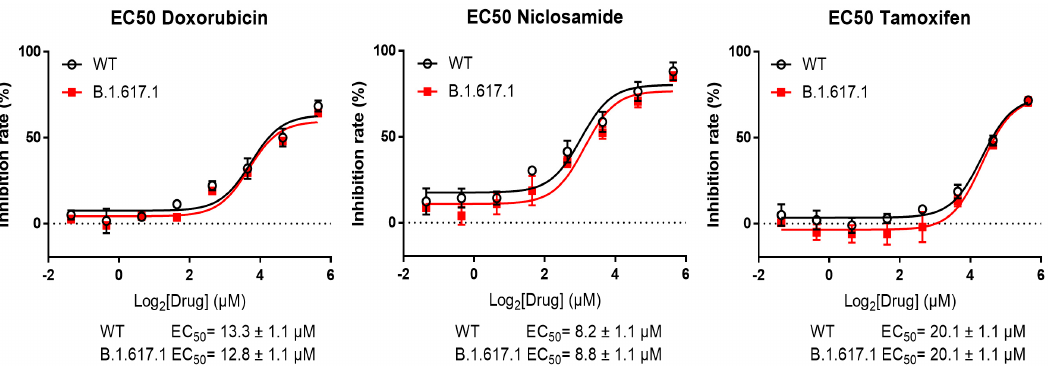
Figure 6. RBD attachment assay in wild-type and B.1.617.1 -variant SARS-CoV-2. EC 50 profiles display the inhibitory effect of each compound on RBD attachment. The x-axis represents the compound concentration in log 2 scale; the y-axis represents the inhibition rate.